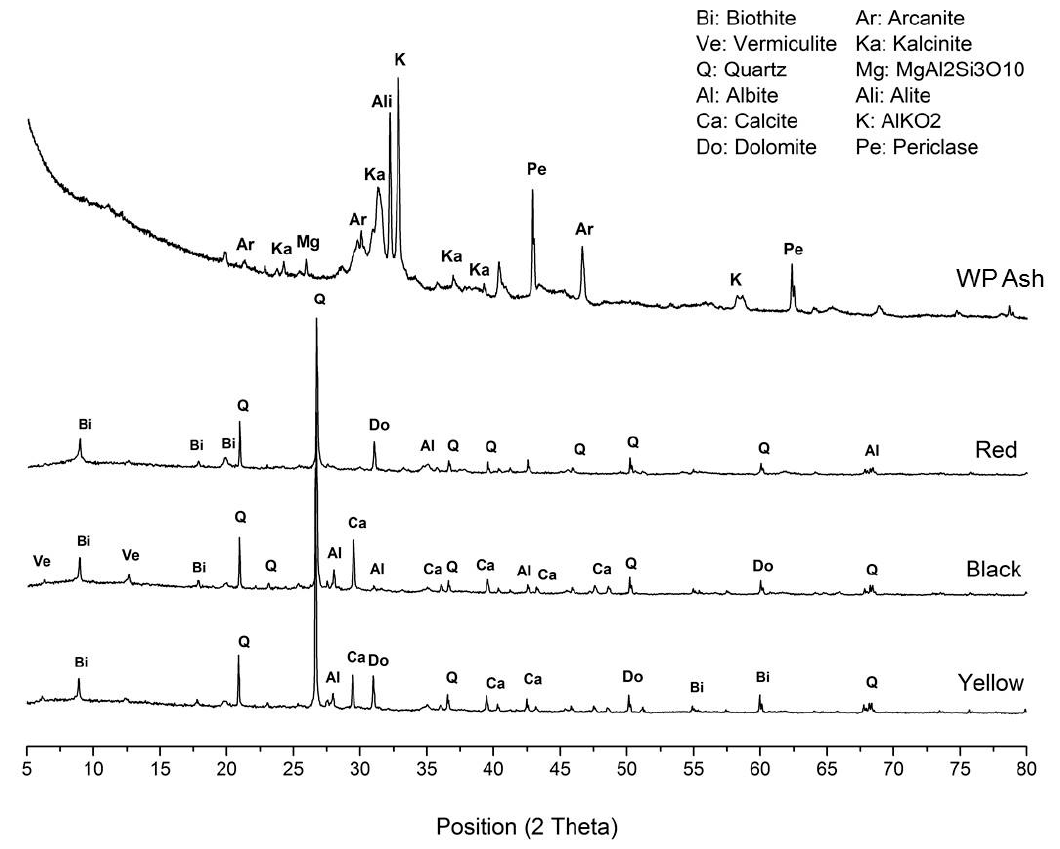
Figure 6. Wet pomace and clays diffractograms.